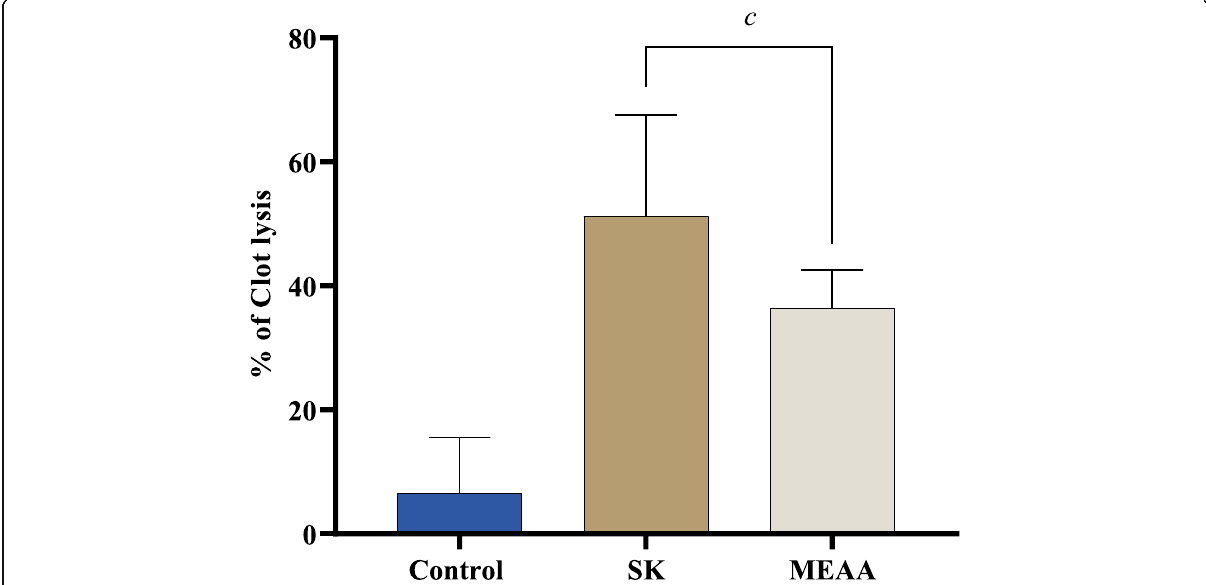
Fig. 5 Methanol leaves extract of A. auriculiformis (MEAA) and standard drug streptokinase (SK) effects on the clot lysis of blood. Values are represented in Mean ± SEM ( n = 6). c p < 0.001 were statistically significant in comparison with the negative control (water) followed by one-way